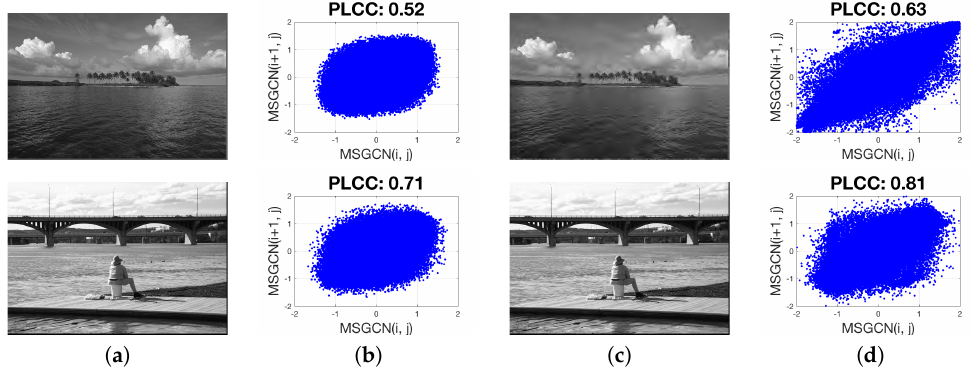
Figure 2. ( a ) Reference images from the LIVE database [40], ( b ) Scatter plot of adjacent pristine MSGCN coefficients, ( c ) JP2K compressed images and ( d ) Scatter plot of adjacent distorted MSGCN coefficients. The